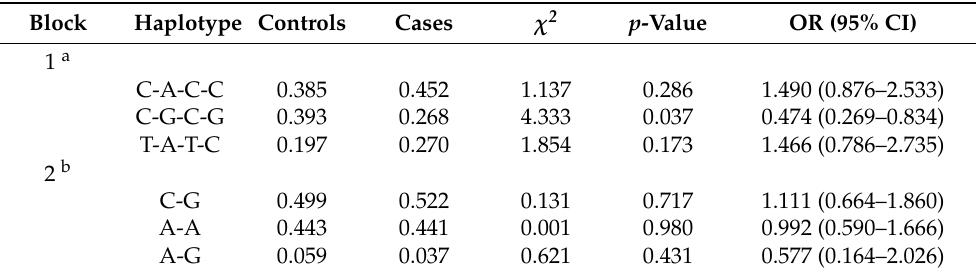
Table 5. Haplotype frequencies of the SNPs in the COMT gene in the PARIs cases and the non-PARI